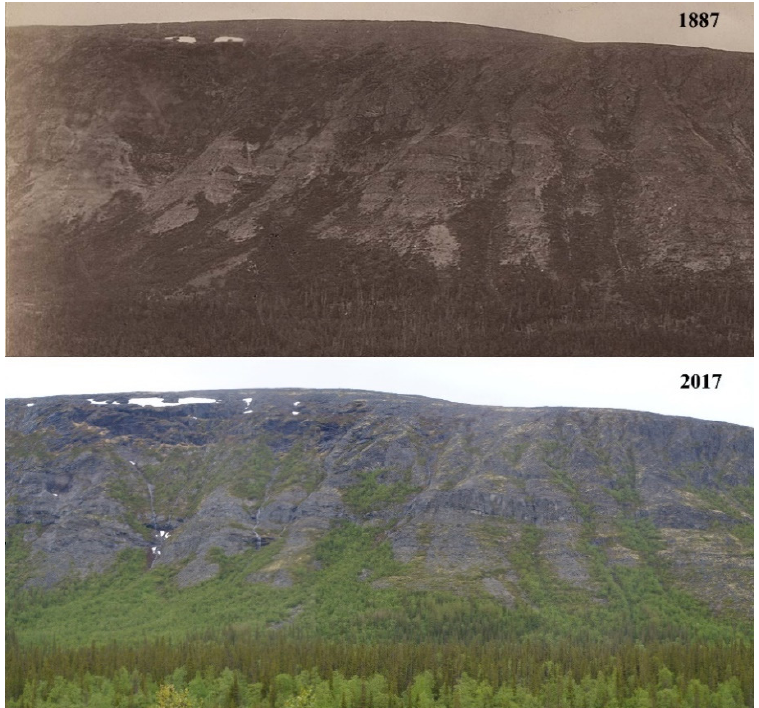
Figure 1. View of a section of the slope of the Lovozerskie Tundry massif (Kola Peninsula), adjacent to Lake Seidozero from the north (69.82° N, 34.94° E). The photos were taken in 1887 by Wilhelm Ramsay during the Great Kola Expedition and in 2017 by Dmitry Moiseev.